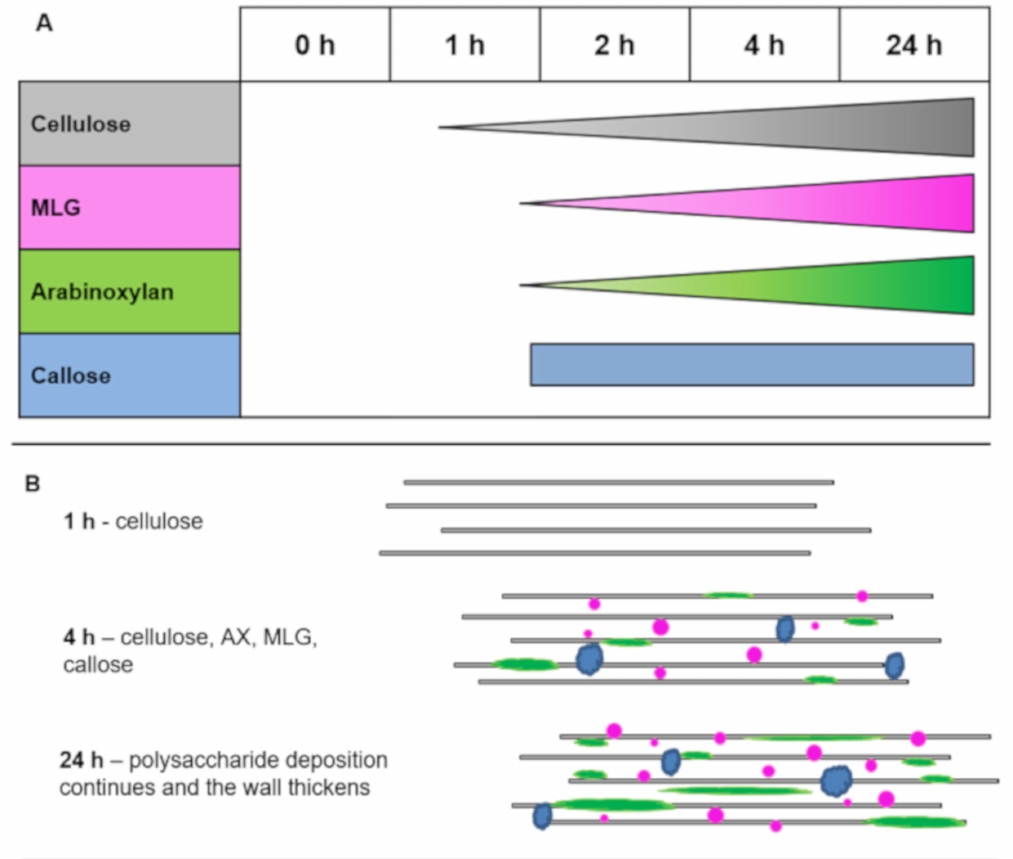
Figure 8. Summary of the timing of deposition of cellulose, MLG, AX, and callose in Lolium SCC. ( A ) Cellulose deposition starts first, followed by the other three polysaccharides. The amount of cellulose, MLG, and AX in the cell walls increases throughout time; however, the amount of callose appears to be quite stable. ( B ) Summary of polysaccharide deposition in the Lolium SCC cell wall through